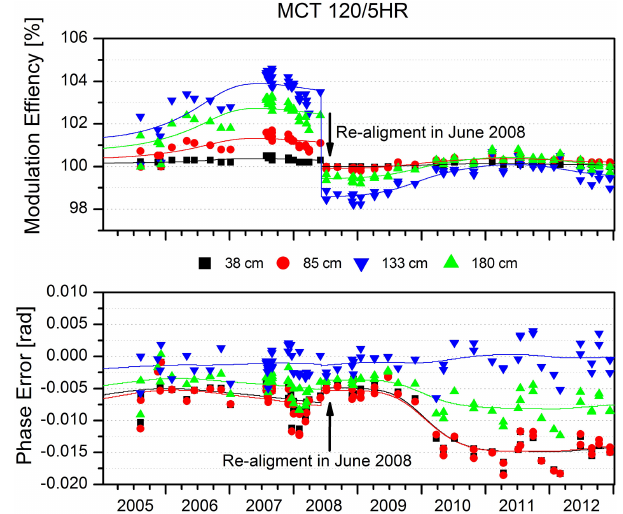
Figure 2. Times series of the modulation efficiency amplitude [%] and phase error [rad] at different optical path differences (OPD) for the MCT detector of the Izaña spectrometer 120 / 5HR. Indi- vidual data points indicate individual low pressure N 2 O cell mea- surements. The lines are the smoothed efficiency/phase error curves used during the FTIR retrievals. Black at 38cm, red at 85cm, green at 133cm, and blue at 180cm.